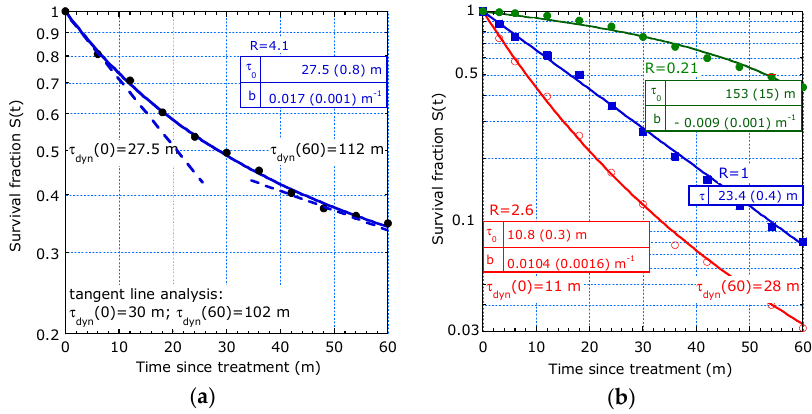
Figure 6. Decreasing and increasing hazards: ( a ) Mixture of tumour stages from gastric cancer modelled with sliding- τ in favour of filtering out defects with tangent lines at τ dyn (0) and τ dyn ( t max ) (dashed lines) ([6], Figure 1); ( b ) Sliding- τ model with accelerated aging ( b < 0, dots), exponential decay ( b ≈ 0, squares) and filtering out defects ( b > 0, circles) ([7], Figure 3). 6. Study from Razenberg et al. [8] on 4430 patients with CRC and PC treated with cytoreductive surgery (CRS) and hyperthermic intraperitoneal chemotherapy (HIPEC).